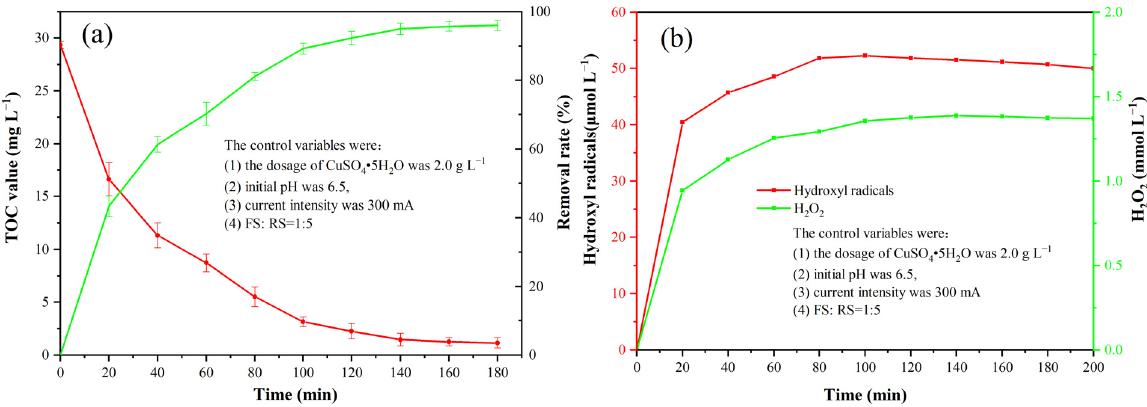
Figure 9. By the 3D-EF system: ( a ) removal rate of TOC; ( b ) concentration of • OH and H 2 O 2 .